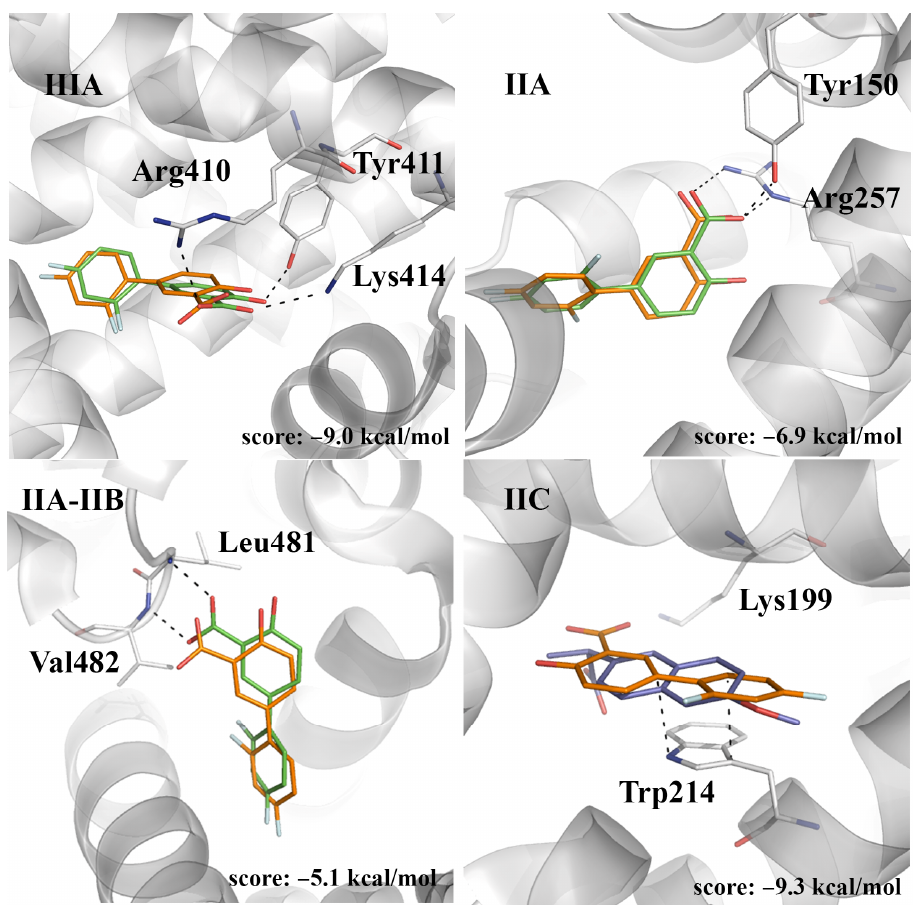
Figure 5. The predicted pose of diflunisal bound to sites IIIA, IIA, IIA-IIB, and IIC. The crystallo- graphic poses of diflunisal (bound at sites IIIA, IIA, and IIA-IIB; PDB entry 2BXE), and naproxen (bound at site IIC; PDB entry 4OR0) are shown as sticks (C atoms in green and dark blue, respectively). The docked pose of diflunisal is shown with C atoms as orange sticks. The protein back- bone is displayed as a gray cartoon. Selected interactions with HSA residues are represented as dashed lines.